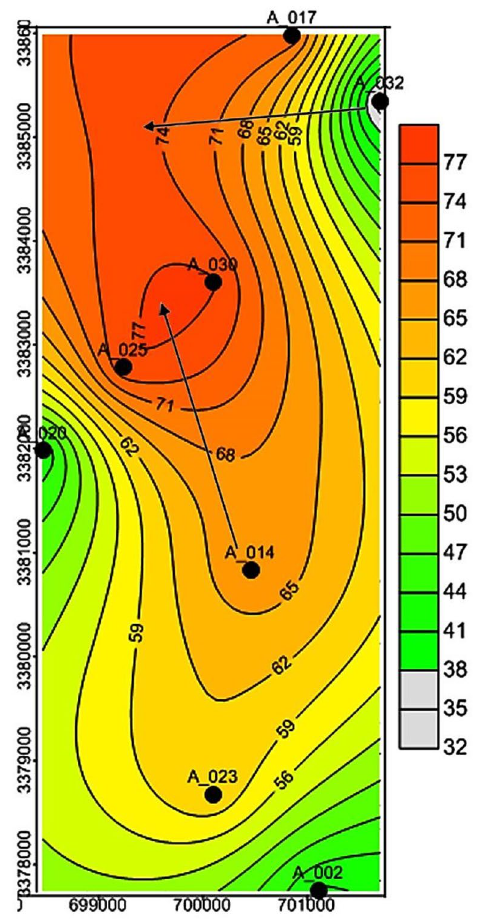
Fig. 12 Iso-parametric map representing the net-pay thickness (in feet) of the Albian sequence in the SWM Oil Field. Arrows refer to the direction of increasing